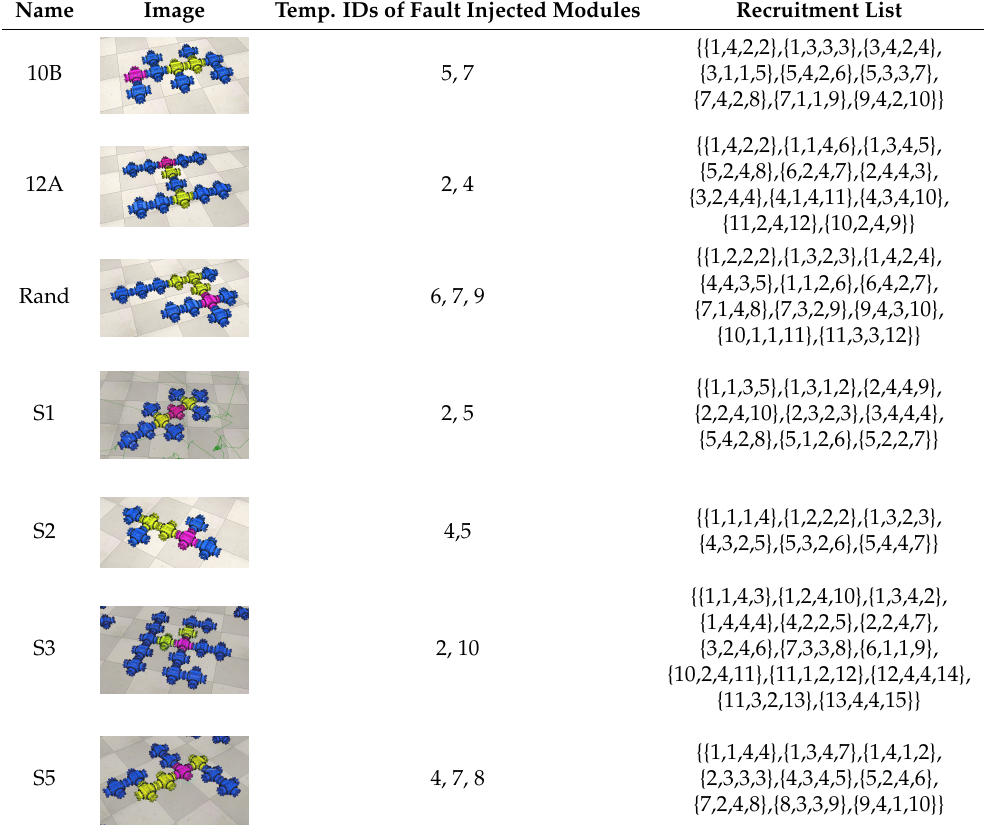
Table 3. Structures used in the self-repair experiments, each structure is named with a Recruitment List and an image displayed. The seed robot (pink) and those that were injected with faults (yellow) are highlighted. Here, 10B, 12A and Rand are sourced from [10], the rest are derived from the self-assembly experiments, with S2 enlarged and modified to make the repair task more interesting.